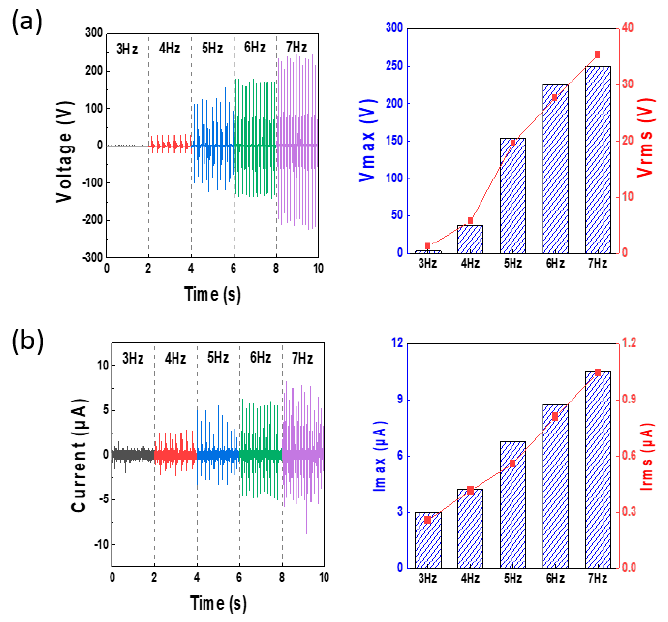
Figure 3. Plots depicting changes in output according to changes in frequency: ( a , b ) voltage and current occurring from 3 to 7 Hz.